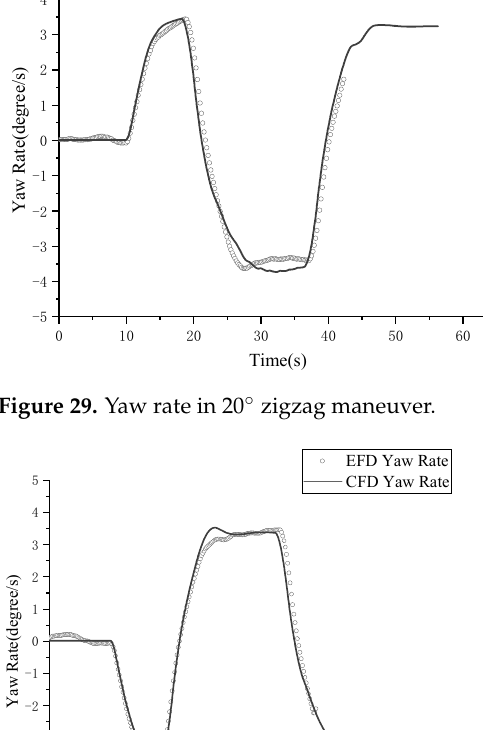
Figure 28. Heading and rudder angle in 20° zigzag maneuver.